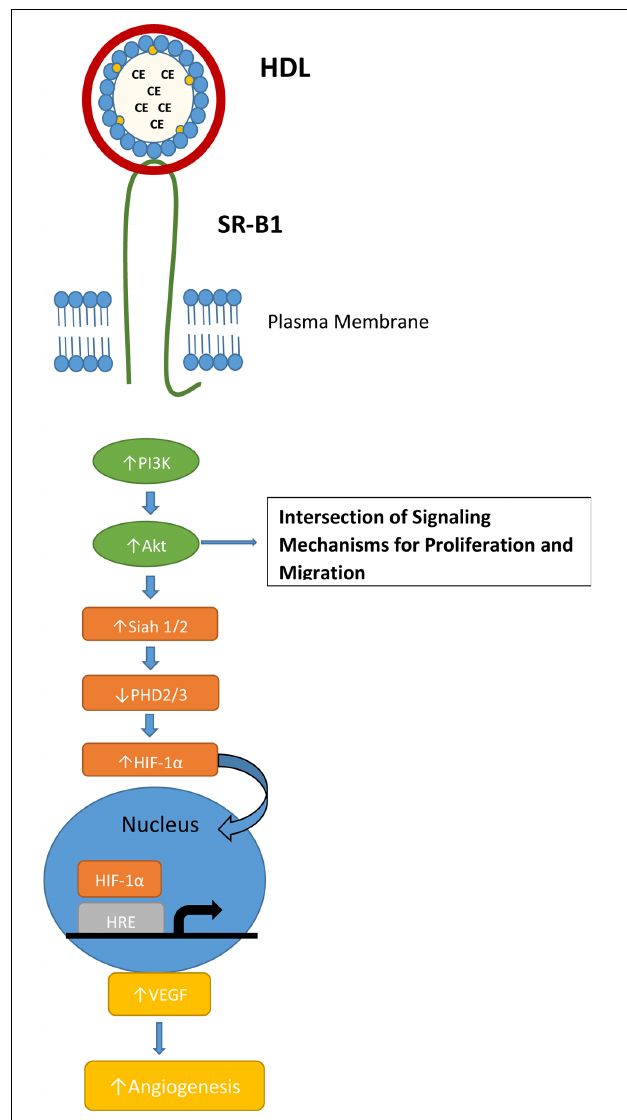
FIGURE 2 | SR-B1 signaling pathway for normal hypoxia-induced angiogenesis. Interaction of HDL and SR-B1 activates the PI3K/Akt pathway leading to HIF-1 α translocation to the nucleus and transcription of VEGF. HDL treatment and over-expression of SR-B1 has been shown to activate the PI3K/Akt pathway in tumor cells and stimulate proliferation and